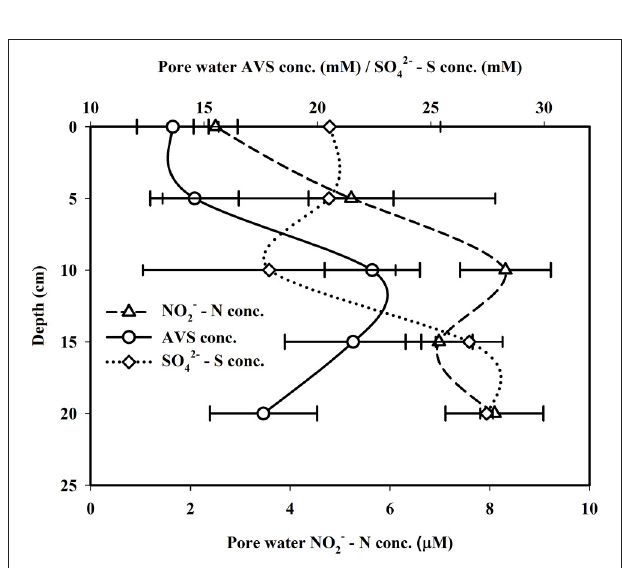
FIGURE 3 | Vertical distributions of pore water NO − 2 - N, SO 2 − 4 - S, and AVS concentrations in mangrove sediment.